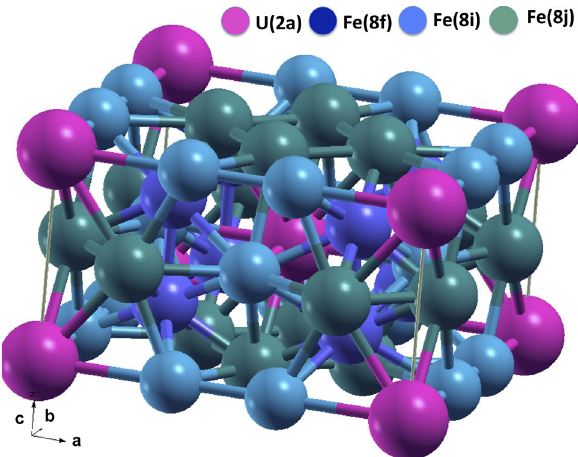
Figure 2. The ThMn 12 -type lattice of UFe 12 with uranium atoms in 2a Wyckoff position shown in pink, and the Fe atoms in 8f (dark blue), 8j (light blue), and 8i (green) Wyckoff positions. The uranium and iron magnetic moments are aligned along the [001] direction.